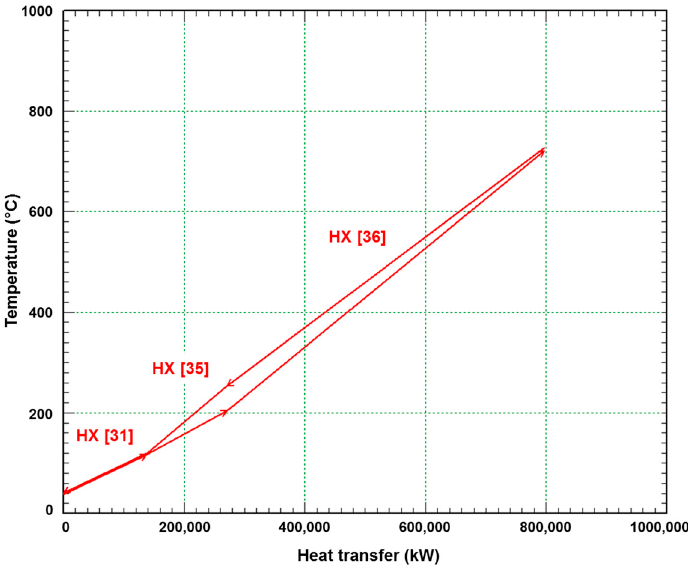
Figure 11. Temperature-heat exchanger diagram of the recuperator in the optimized case. Table 3. Comparison between Allam cycle configurations: base case vs. optimized case.